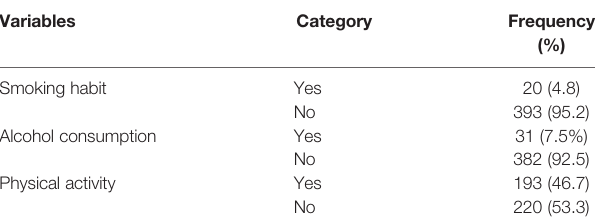
TABLE 3 | Lifestyle characteristics of participants (N =